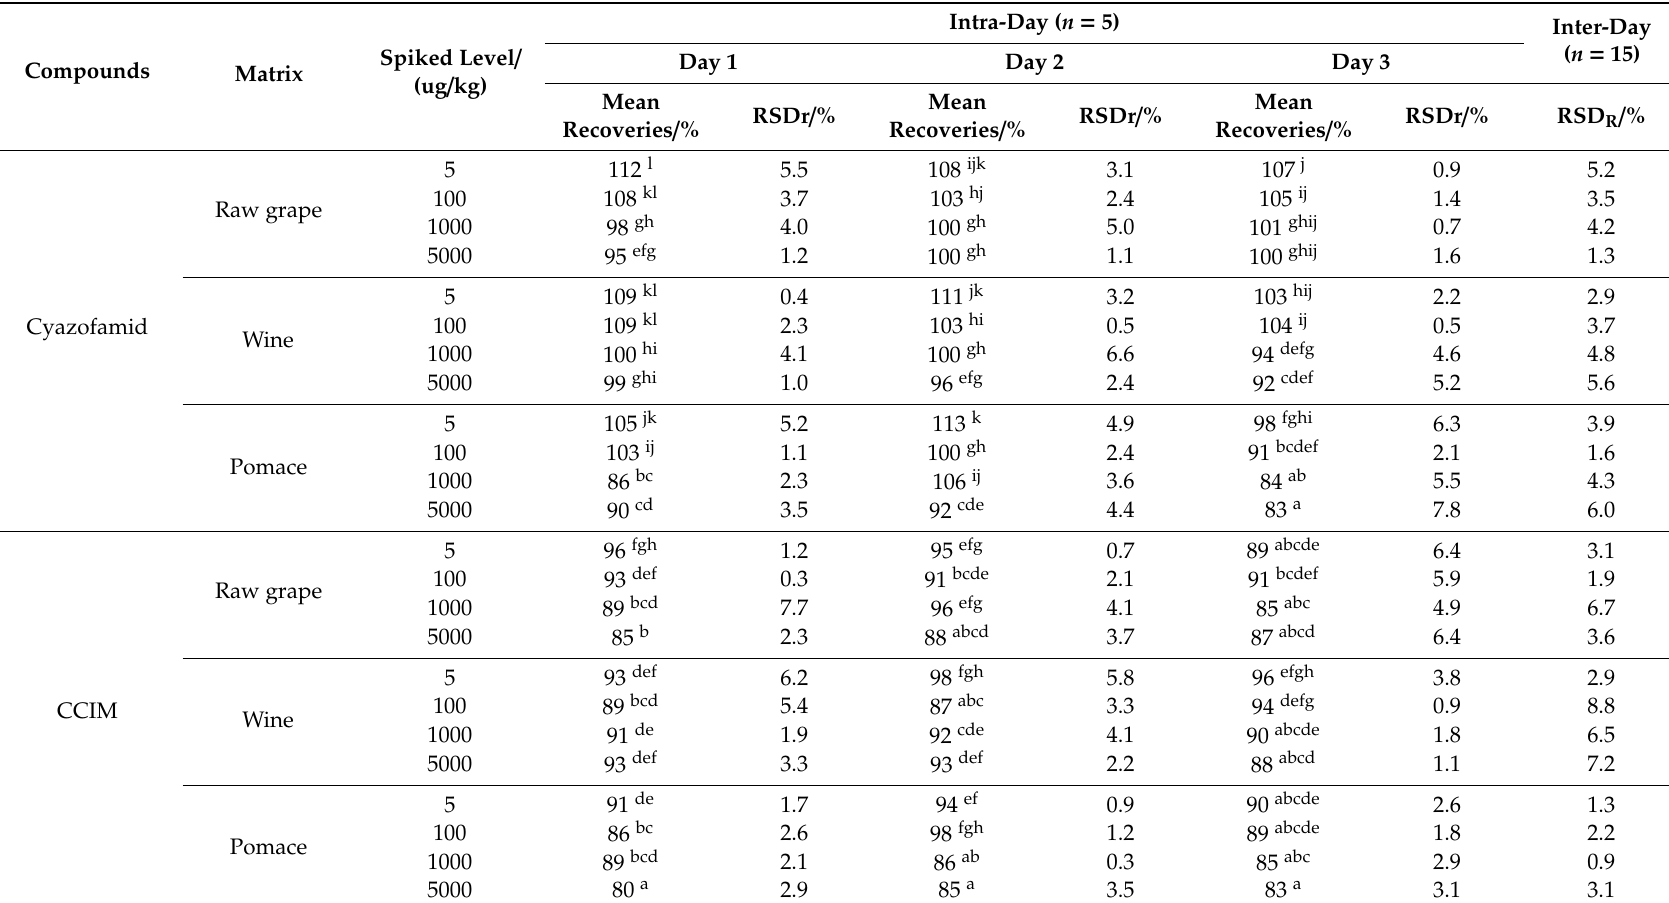
Table 1. Accuracy and precision of the proposed method in grape samples at four spiked